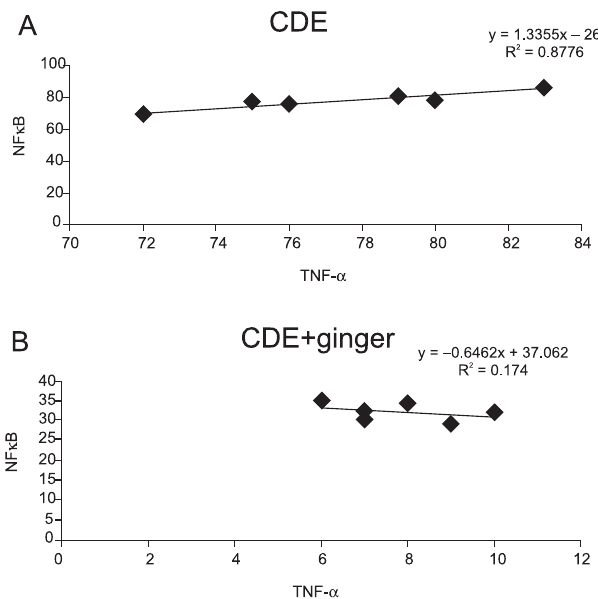
Figure 6 - Correlation coefficient between NFkB and TNF- α expressions in (A) CDE group and in (B) CDE supplemented with ginger extract (100 mg/kg body weight) group. Significant correlation was observed between NFkB and TNF- α in CDE group (r = 0.8776, p < 0.01) but not in the CDE group treated with ginger